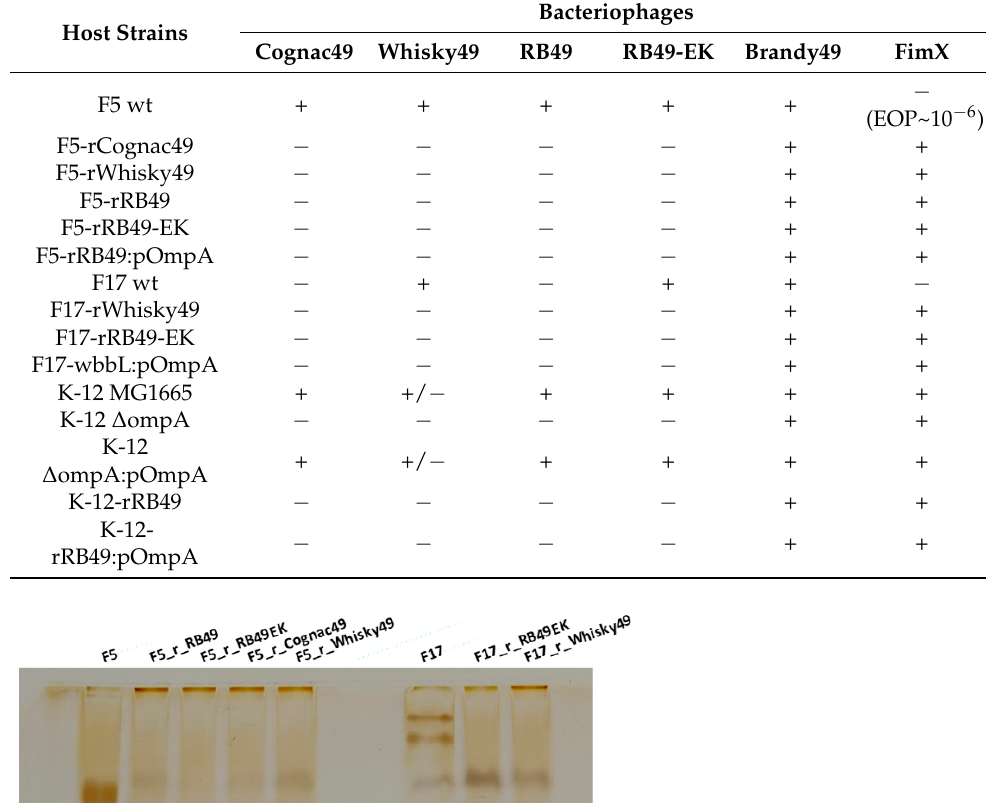
Table 2. Plaque formation on E. coli strains, selected for phage resistance.